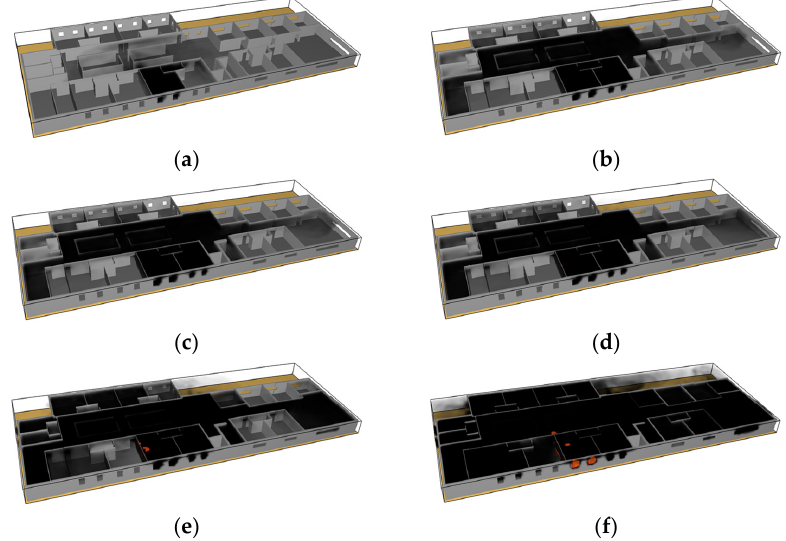
Figure 6. ( a ) t = 100 s; ( b ) t = 204 s (Route B fail); ( c ) t = 211 s (Elevator fail); ( d ) t = 227 s (Route A fail); ( e ) t = 300 s; ( f ) t = 500 s.